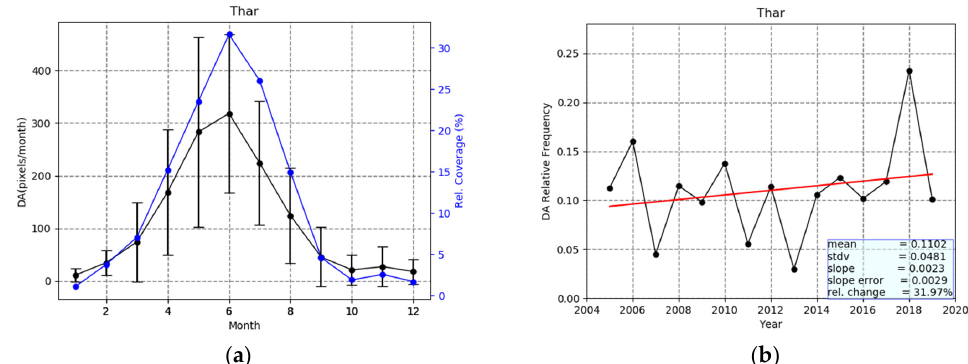
Figure 15. ( a ) Intra-annual variability of the 2005–2019 averages of the total absolute number of grid cells (1 ◦ × 1 ◦ ) where dust aerosols (DA) were detected over the Thar desert by the satellite algorithm (left axis) and the percent coverage of the region by dusty grid cells (right axis). The error bars represent the year-by-year variability by means of computed 2005–2019 standard deviations. ( b ) Inter-annual variability and linear trend of the relative frequency of dust aerosols (DA) over